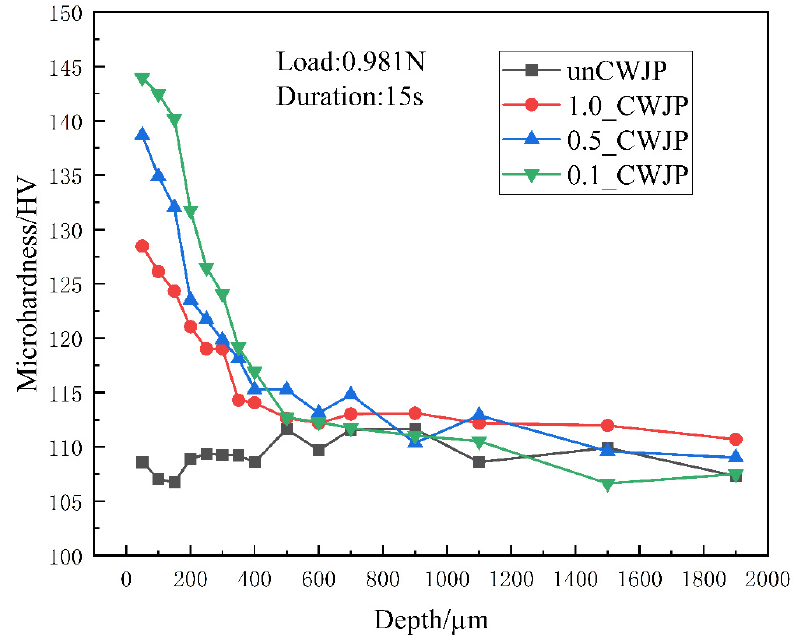
Figure 4. In-depth microhardness distribution curves.